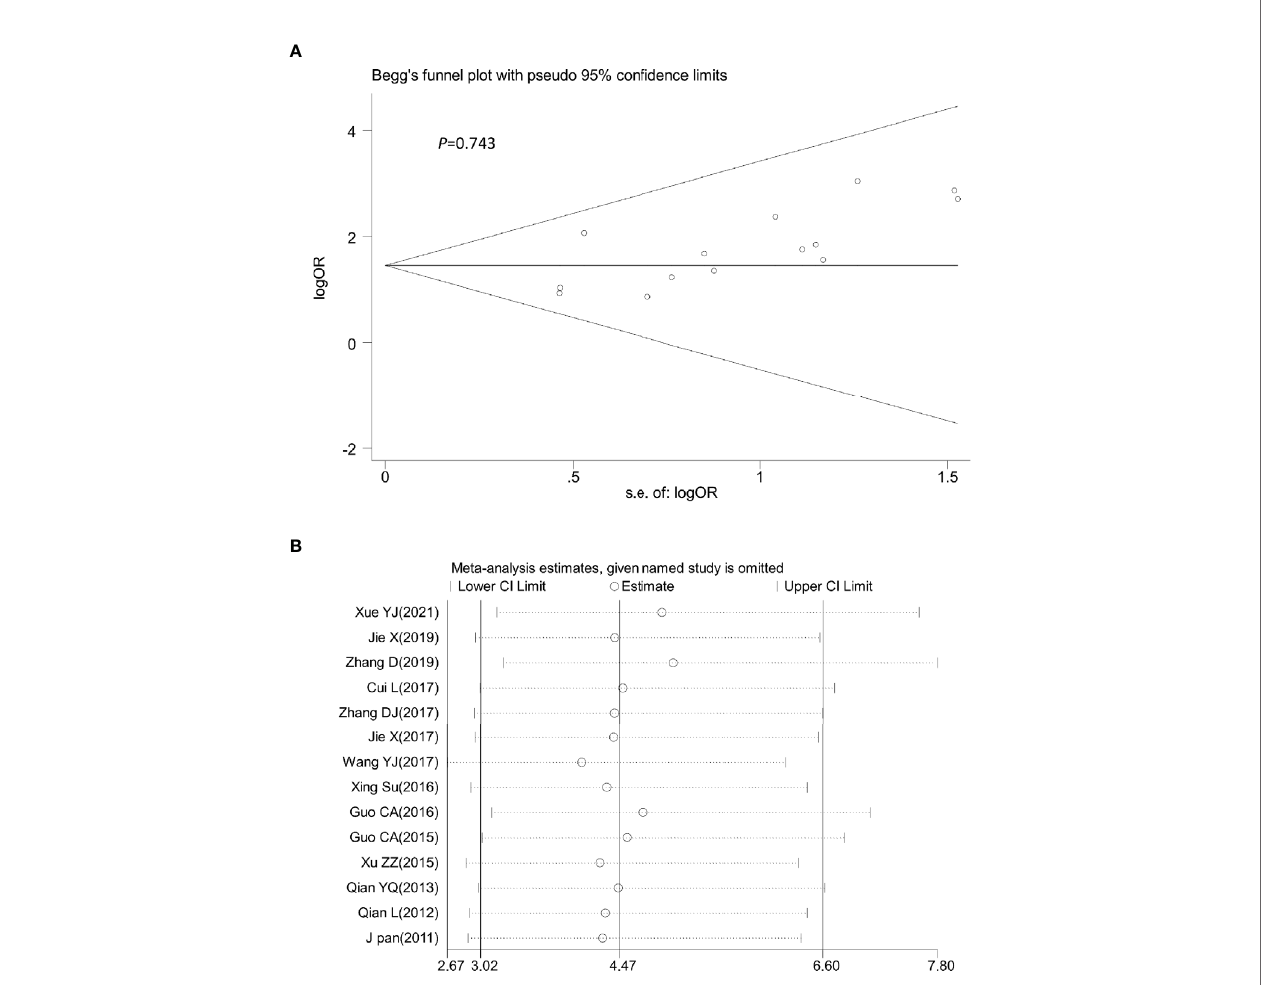
FIGURE 11 | Begg ’ s funnel plot (A) and sensitivity analysis (B) of all the included studies for the analysis of ORR. Begg ’ s test ( p = 0.743). ORR: objective tumor